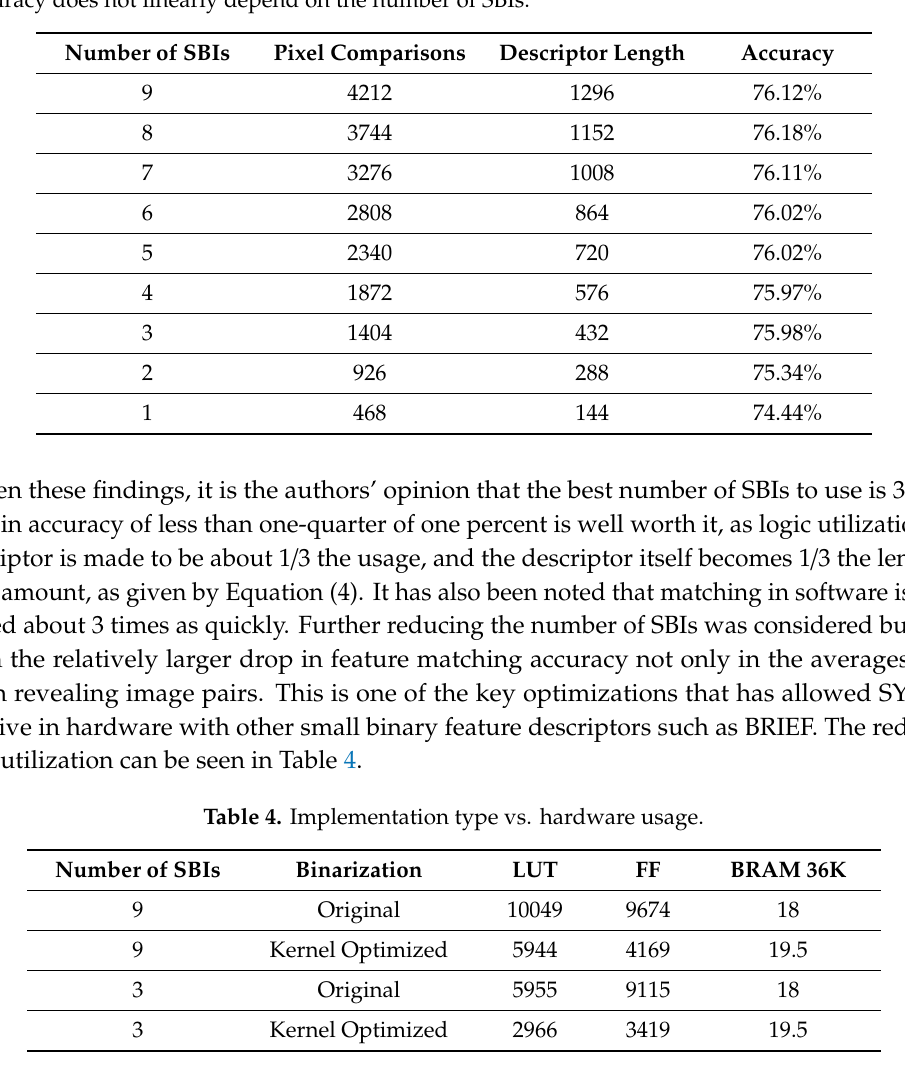
Figure 10. Number of SBIs (synthetic basis images) vs. average feature matching accuracy across all image sequences. Table 3. Showing linear dependency on number of SBIs for pixel comparisons and descriptor length. Accuracy does not linearly depend on the number of SBIs.